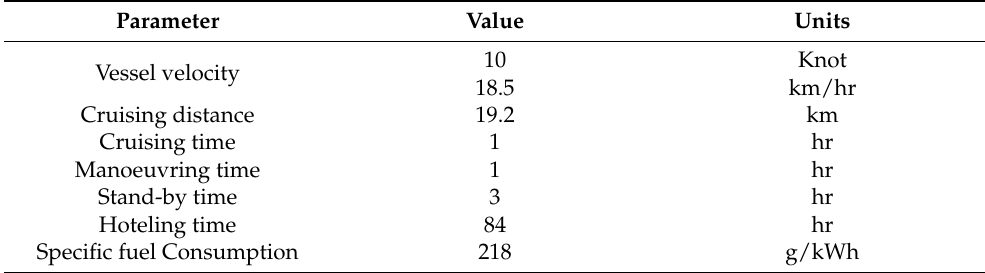
Table A6. Calculation basis parameters for